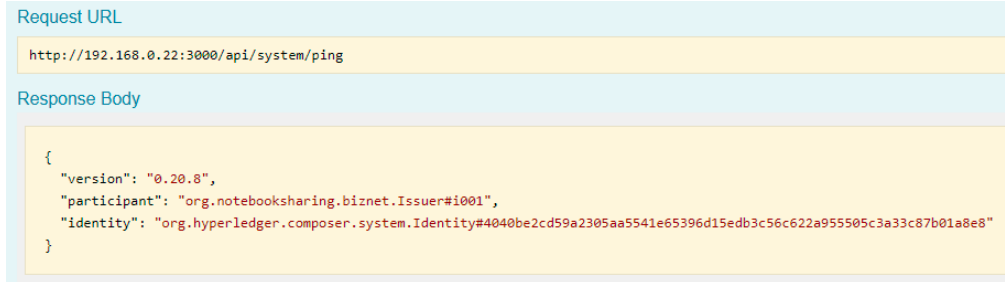
Figure 17. Transaction test in the Composer REST